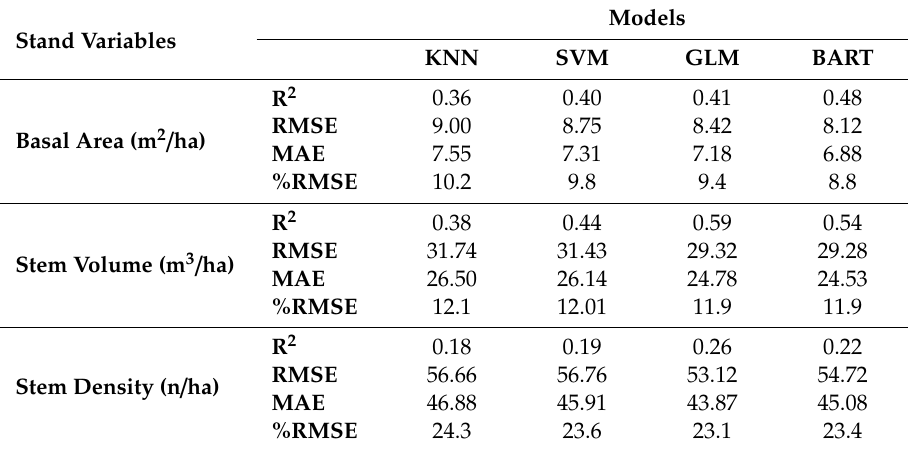
Table 5. Performance evaluation of the KNN, SVM, GLM, and